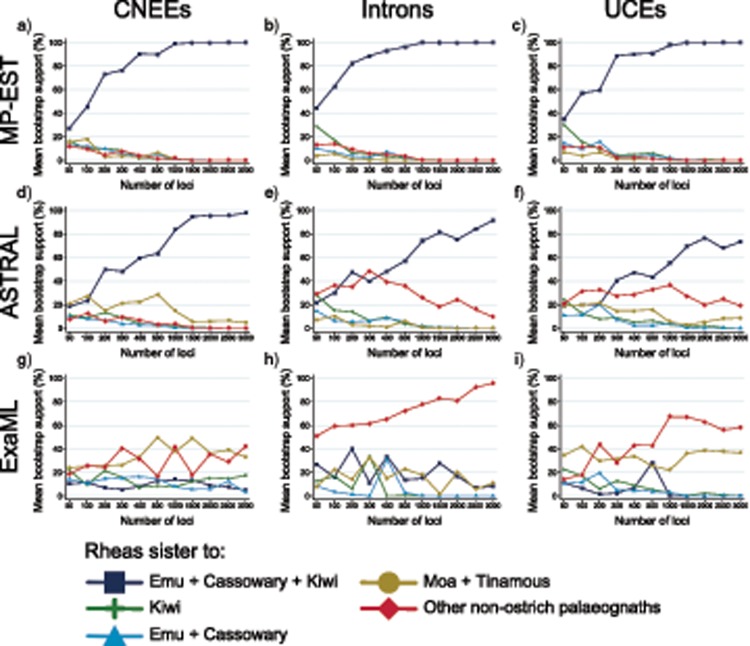
Support for alternative hypotheses of the sister group to rheas from phylogenomic subsampling using MP-EST (a–c), ASTRAL (d–f), and ExaML (g–i). Plots display the mean bootstrap support for each hypothesis from 10 replicates of randomly sampled loci within each data set size category (e.g., 50–3000 loci, shown on \documentclass[12pt]{minimal}
\usepackage{amsmath}
\usepackage{wasysym}
\usepackage{amsfonts}
\usepackage{amssymb}
\usepackage{amsbsy}
\usepackage{upgreek}
\usepackage{mathrsfs}
\setlength{\oddsidemargin}{-69pt}
\begin{document}
}{}$CDATA[$CDATA[$x$$\end{document}-axis).